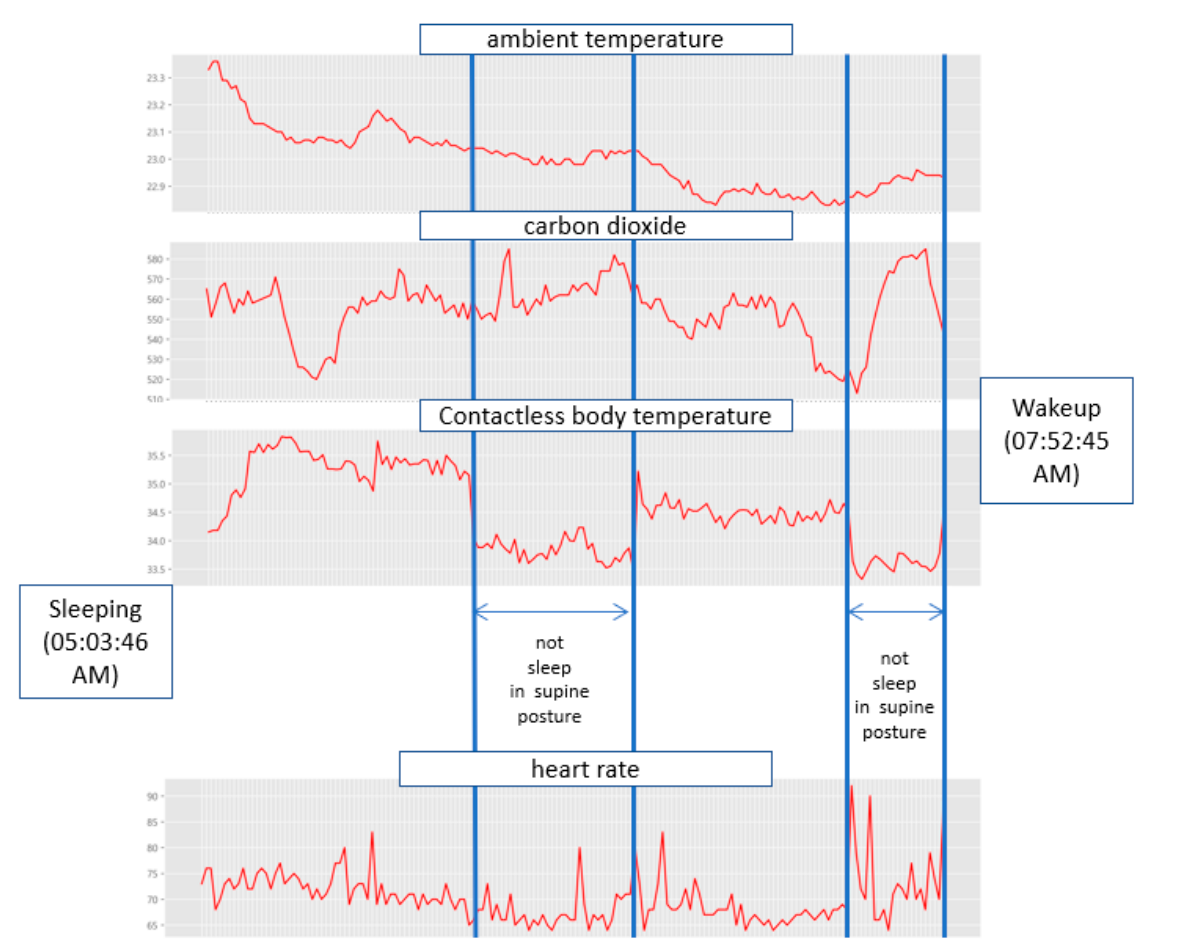
Figure 12. Sleep pattern measurement results (measurement period: 05:03:46 a.m. to 07:52:45 a.m. 22 October 2021).